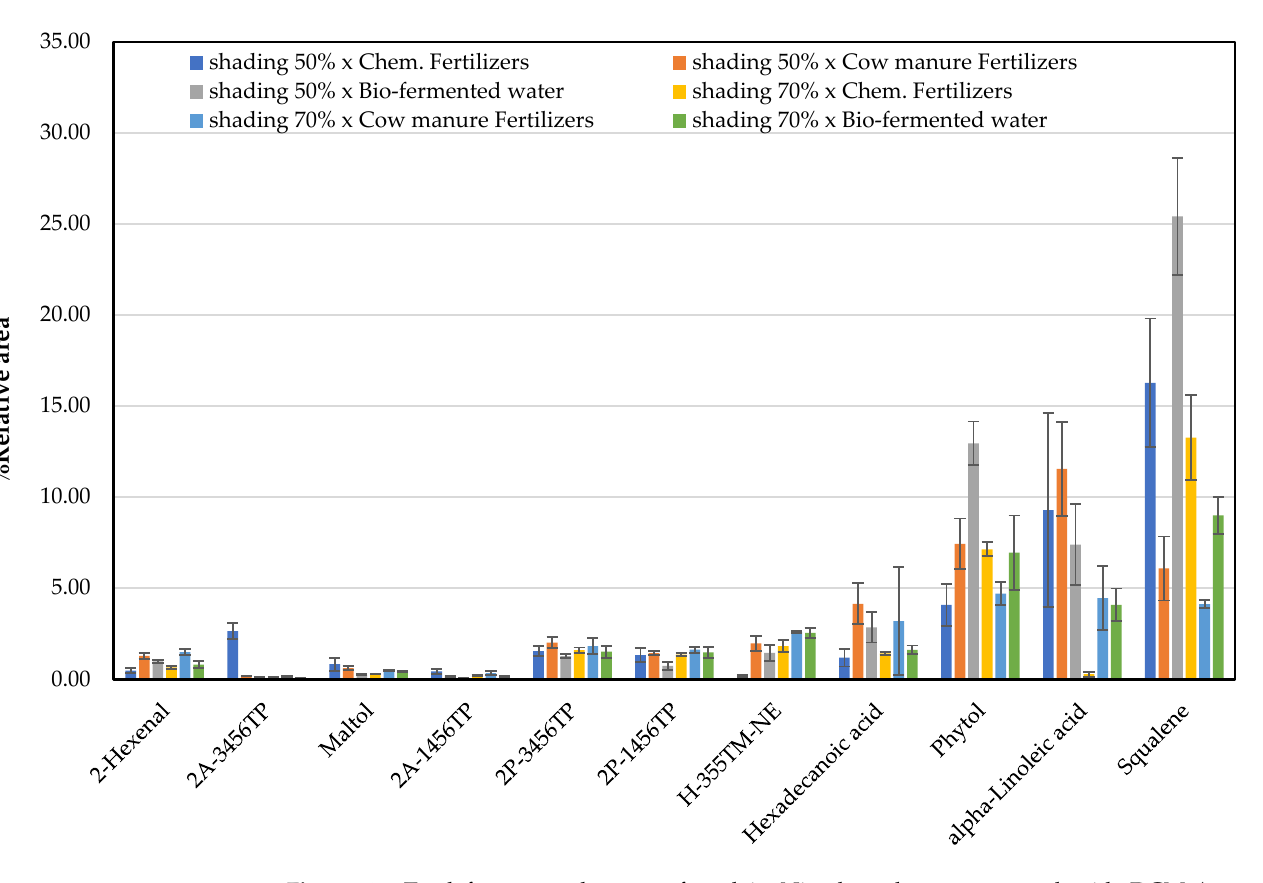
Figure 4. Total fragrant substances found in Niamhom leaves extracted with DCM (except 2-Hexenal from Ethyl Acetate) [Note: 2-Acetyl-3,4,5,6-tetrahydropyridine: 2A-3456TP; 2-Acetyl-1,4,5,6- tetrahydropyridine: 2A-1456TP; 2-Propionyl-3,4,5,6-tetrahydropyridine: 2P-3456TP; 2-Propionyl- 1,4,5,6-tetrahydropyridine: 2P-1456TP; Hexanoic acid, 3,5,5-trimethyl-, nonyl ester: H-355TM-NE;